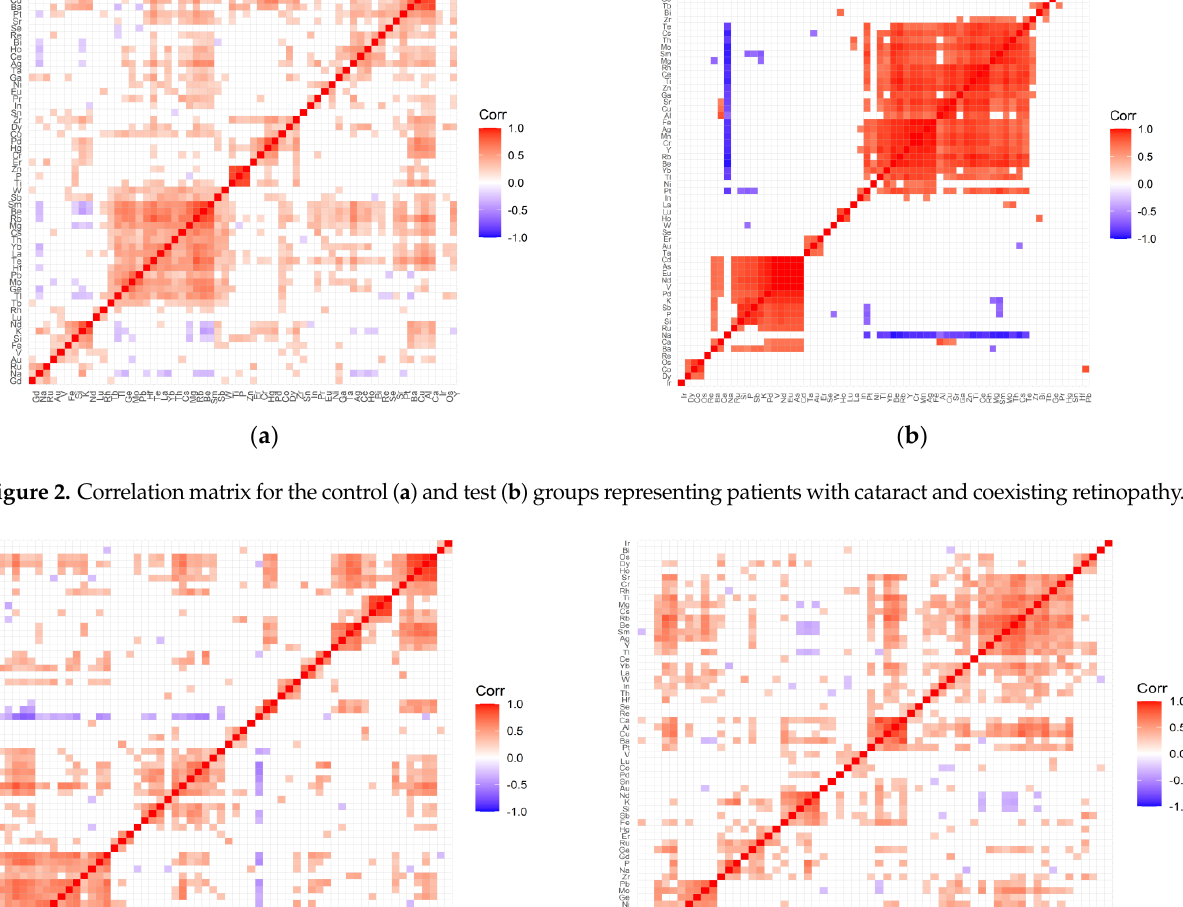
Figure 2. Correlation matrix for the control ( a ) and test ( b ) groups representing patients with cataract and coexisting reti- nopathy.